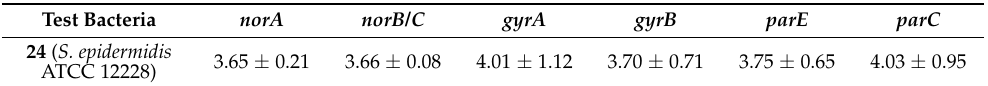
Table 2. Relative fold change in resistance gene expression levels of strain 24 ( S. epidermidis ATCC 12228), which developed resistance to ciprofloxacin after 30 days of exposure to aluminum chloro- hydrate, and control bacteria, which developed resistance to ciprofloxacin only following 30-day subculturing in LB broth without aluminum chlorohydrate.